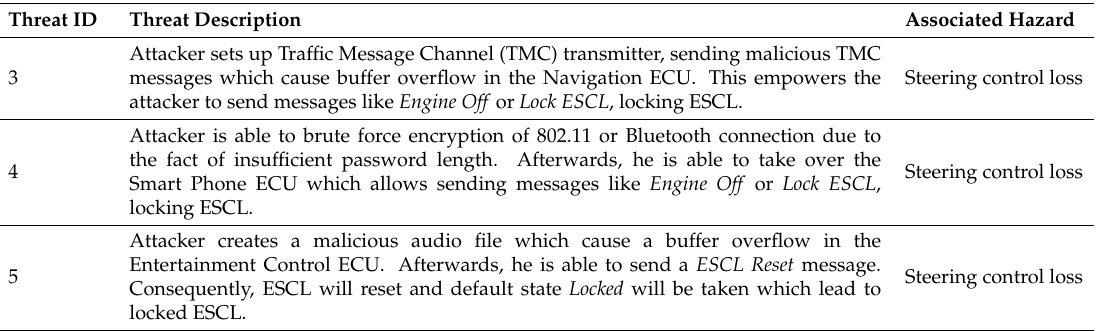
Table 8. Threats regarding to Figure